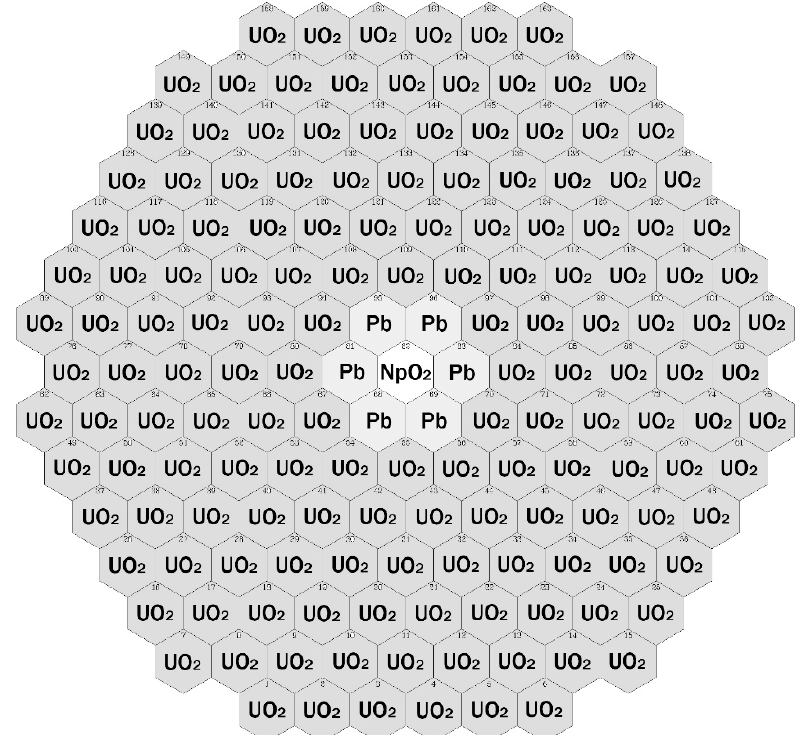
Figure 5. ID disposition in the VVER-1000 core.